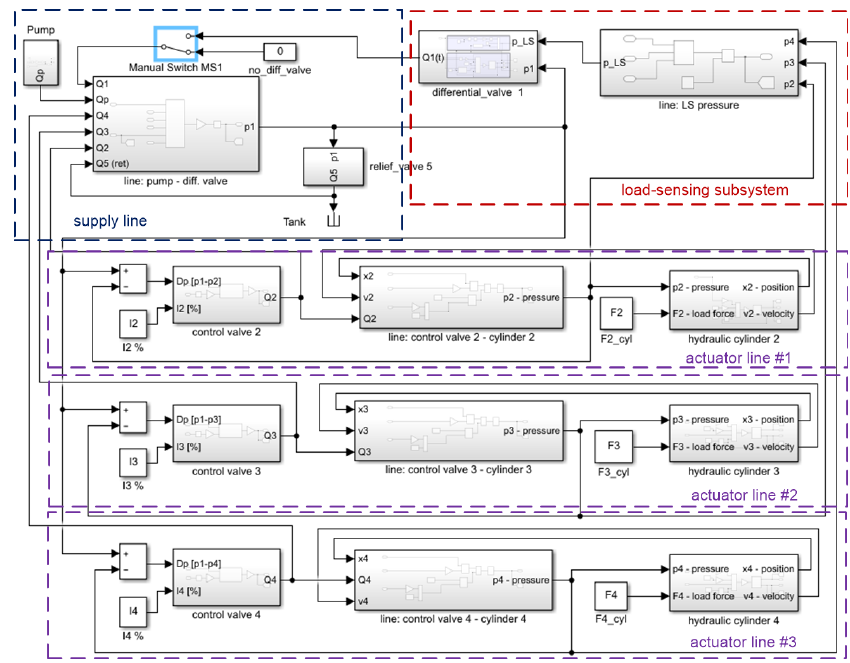
Figure 4. General scheme of the LSB simulation model in